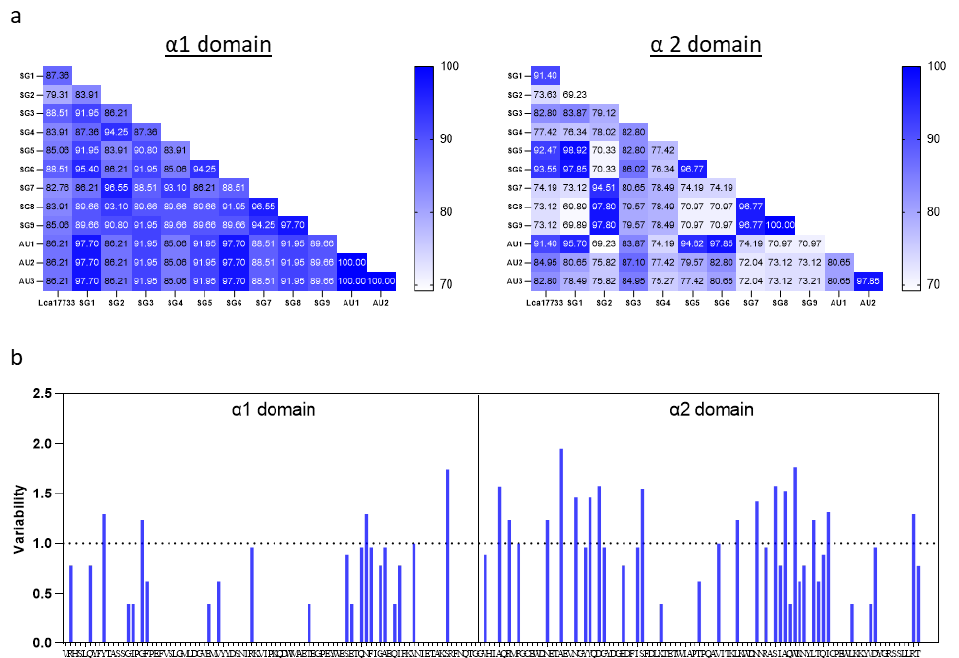
Figure 2. Amino acid identity and sequence variability within the Asian seabass α 1 and α 2 domains. ( a ) Heatmap of amino acid similarity values for Asian seabass and Lca17733 MHC-I α 1 and α 2 domains. ( b ) Sequence variability calculated using the variability metric ( V ) analysis based on the Shannon entropy equation. Sites with V >1 are considered as highly polymorphic in the sequence alignment of the Asian seabass and Lca17733 MHC-I α1 and α2 domains.